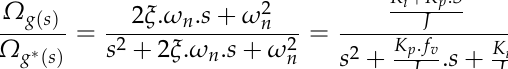
Figure 4. Typical PI controller structure.